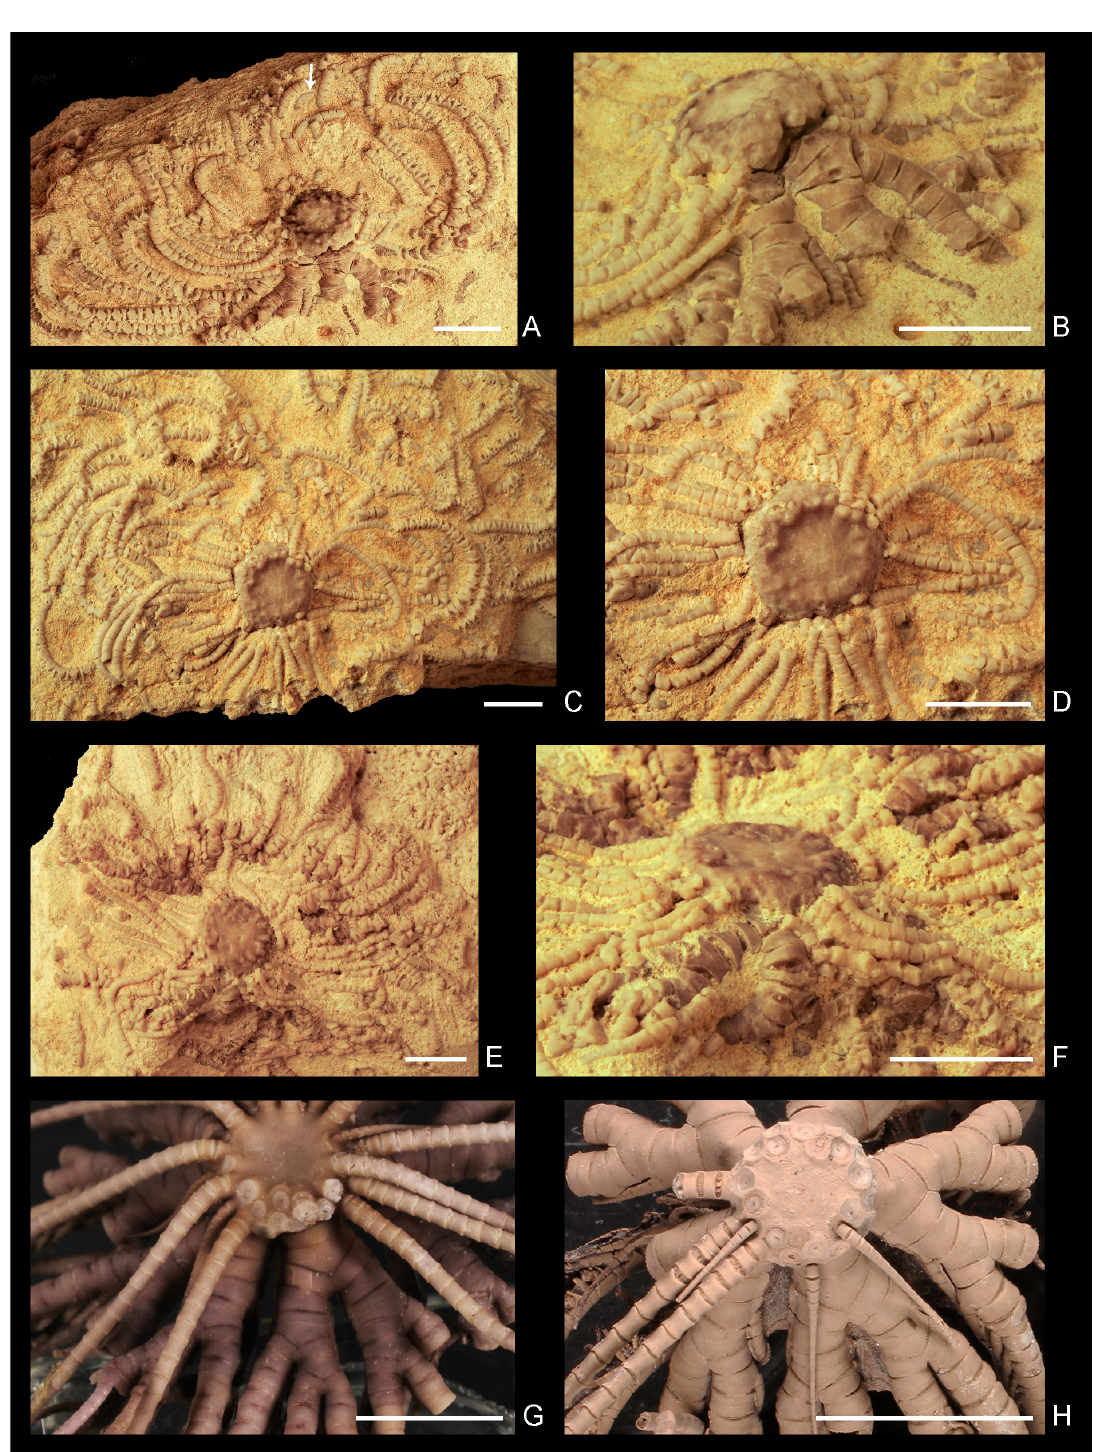
Fig. 2. Aboral view of the proximal crown and centrodorsal in three genera of